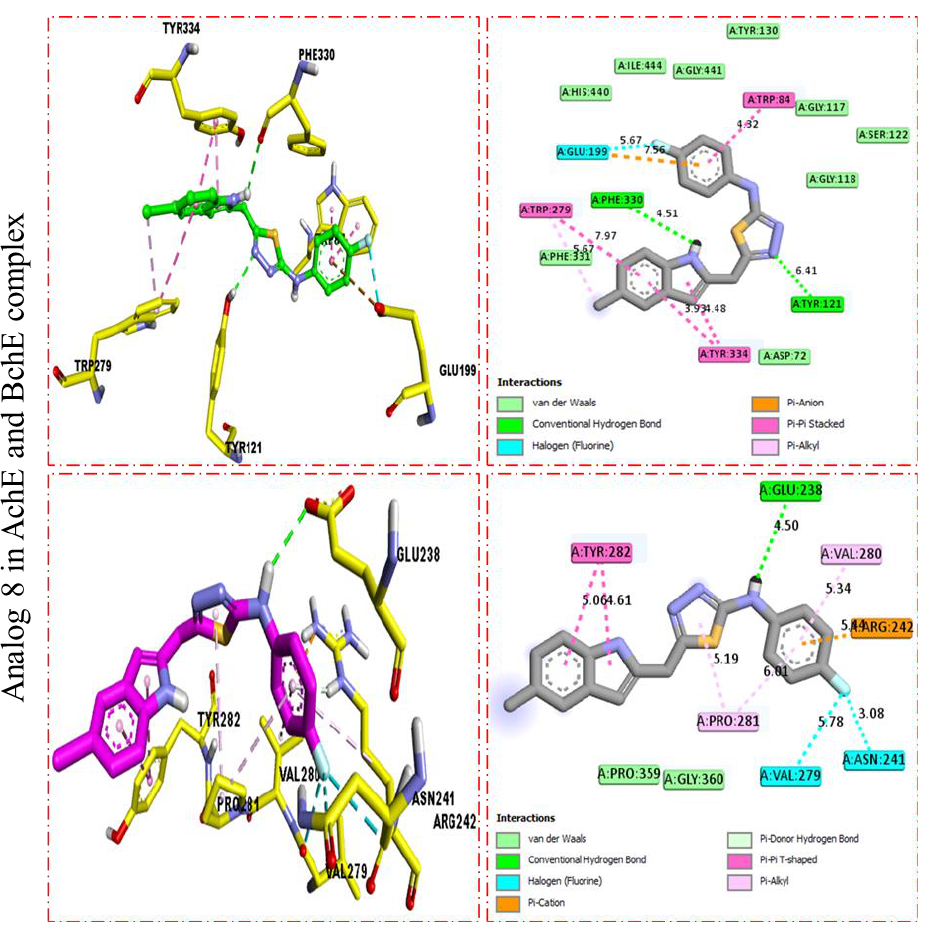
Figure 2. Representation of varied interaction of ligand with enzyme active sites of compound 8 against AchE and BuchE.